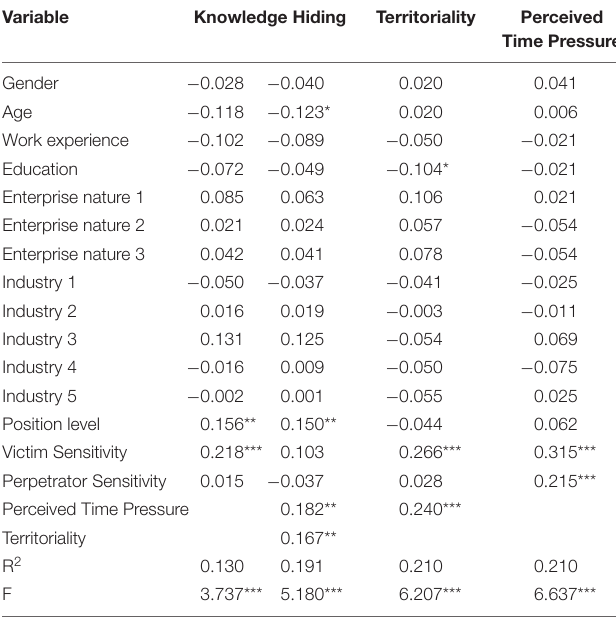
TABLE 5 | The mediating effect of perpetrator sensitivity on knowledge hiding.